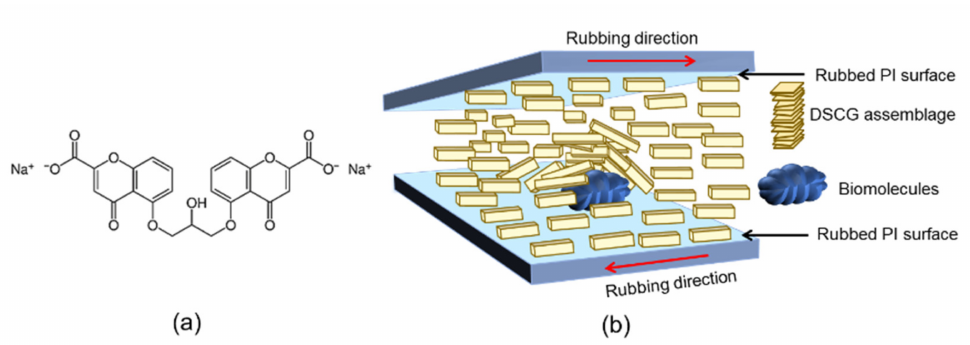
Figure 1. LCLC-based biosensing with planarly aligned DSCG LCLC. ( a ) The chemical structure of DSCG and ( b ) an illustration simulating the disturbance in the planarly aligned columnar stacks of DSCG in the presence of